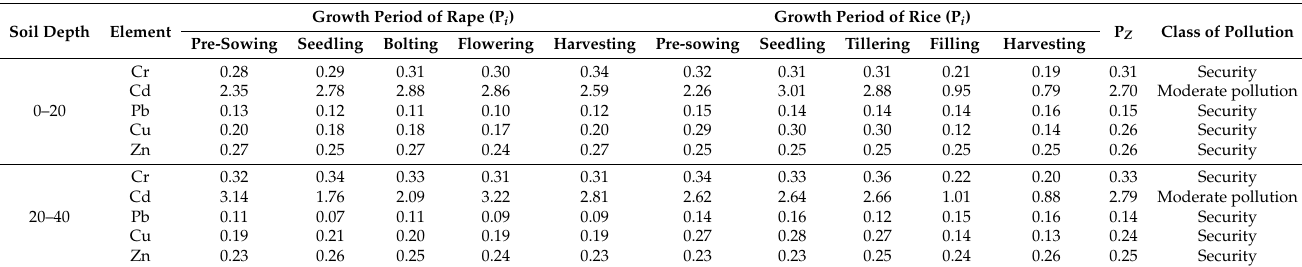
Table 4. Evaluation of soil heavy metal pollution during rice–rape